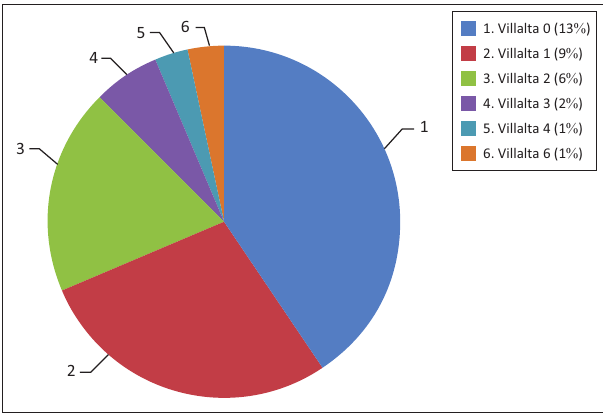
FIGURE 1: Results of the Villalta scores